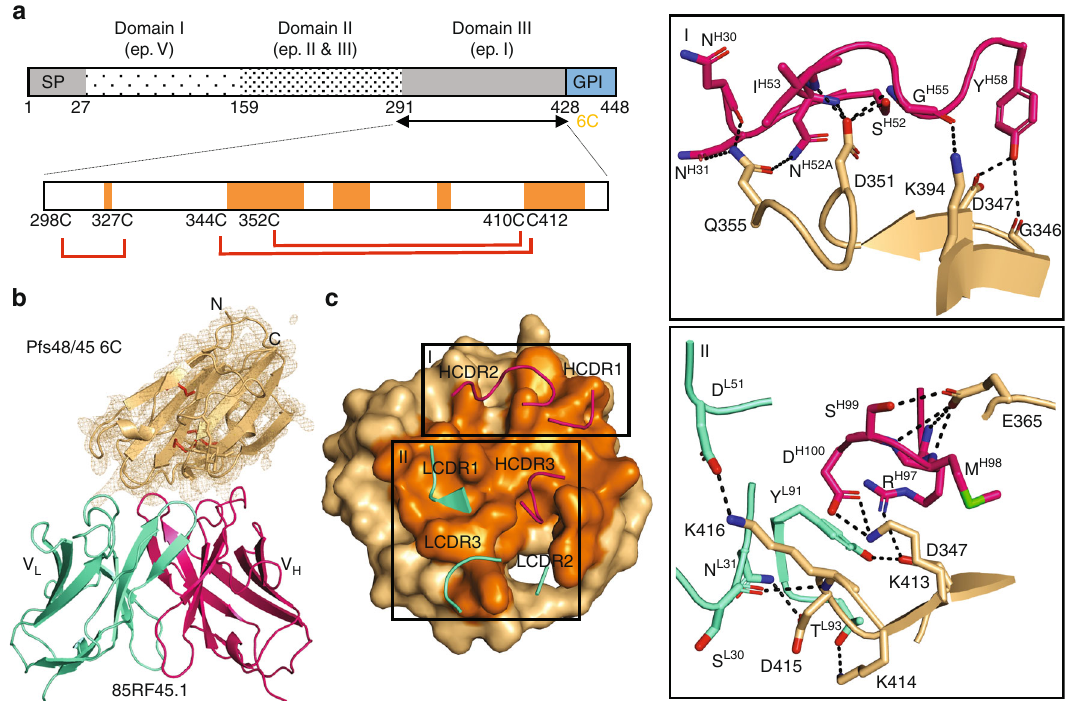
Fig. 1 Recognition of Pfs48/45 6C by potent transmission-blocking mAb 85RF45.1. a Domain organization of Pfs48/45. In the zoom in view of the Pfs48/ 45 6C domain, the dark orange regions represent areas contacted by mAb 85RF45.1. Red lines indicate the disul fi de bonding pattern. SP signal peptide, ep epitope, GPI glycosylphosphatidylinositol anchor. b Overview of the 85RF45.1 Fab-Pfs48/45 6C co-crystal structure rendered as secondary structure cartoon and surface. The orange mesh represents the composite omit electron density map rendered at a 1.2 σ contour level around Pfs48/45 6C. The six- cysteine residues in Pfs48/45 6C are shown as red sticks. The 85RF45.1 light and heavy chains are colored teal and magenta, respectively. Only the Fab variable region is shown for clarity. c Residues of the 85RF45.1 epitope on Pfs48/45 (dark orange surface) are recognized by all six CDRs (secondary structure cartoon). The insets show residues involved in H-bonds and salt bridges (black dashes). Colors are as in